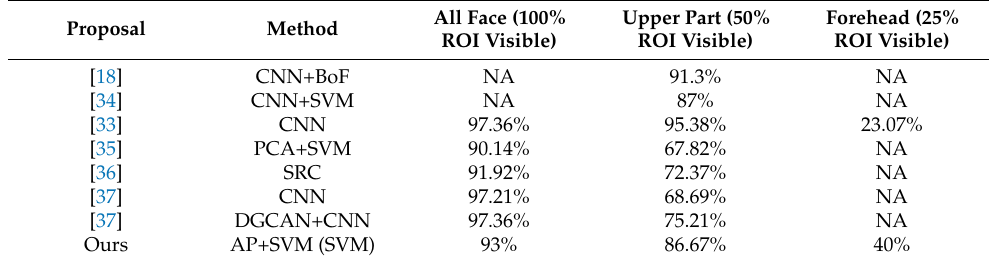
Table 3. Comparison of recognition rates with state-of-art